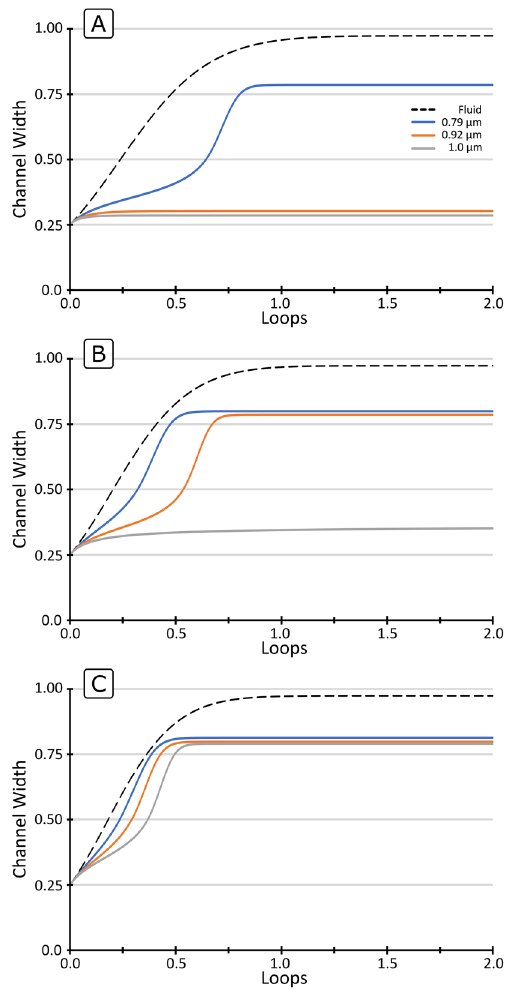
Figure 5. Trajectories of three particle sizes a (0.79, 0.92 and 1.0 µm) in sections with fixed R (300 µm), Q (30 µL/min) and H (14.5 µm). ( A ) W 6.15 µm, ( B ) W 6.65 µm and ( C ) W 7.15